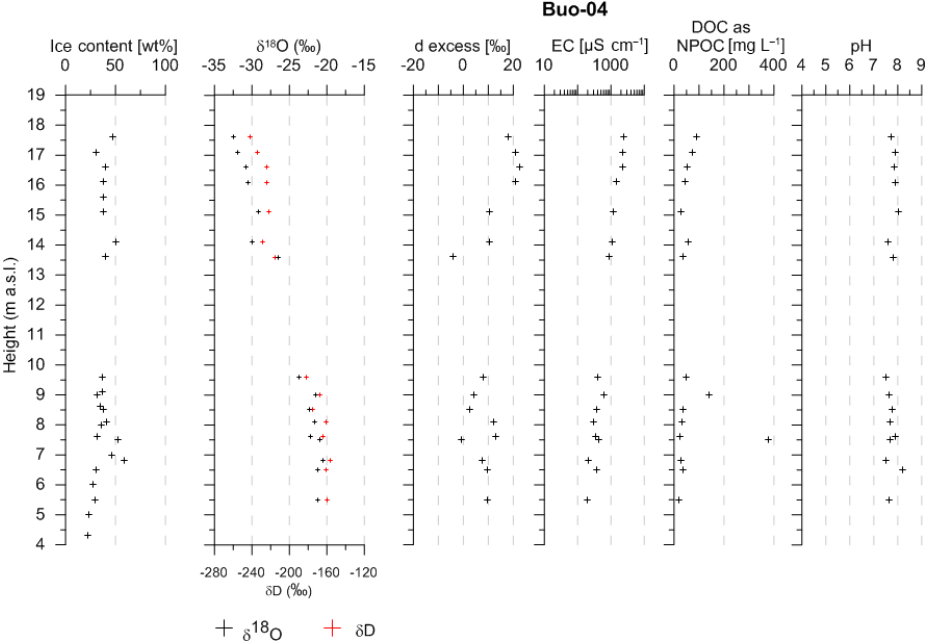
Figure 10. Measurements of ice content, isotope ratios, electrical conductivity (EC), pH, and solutes over height in ma.s.l. for samples from the Buo-04 exposure.